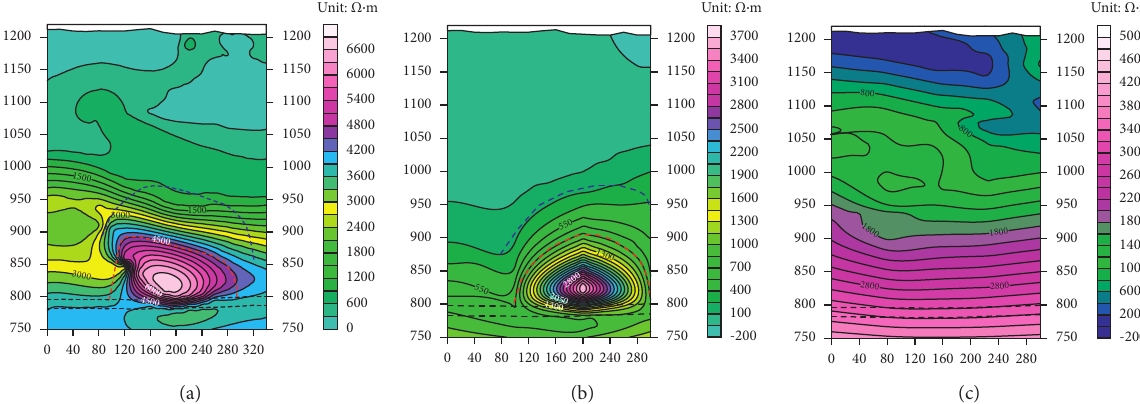
Figure 4: EH-4 two-dimensional inversion profiles of survey line #2. (a) The first stage (May 2011). (b) The second stage (August 2011). (c) The third stage (May 2012).